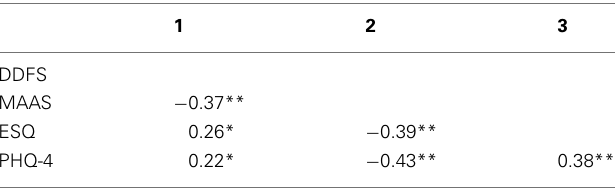
Table 6 | Correlation matrix of Study 2 scales ( N = 100, sample C).